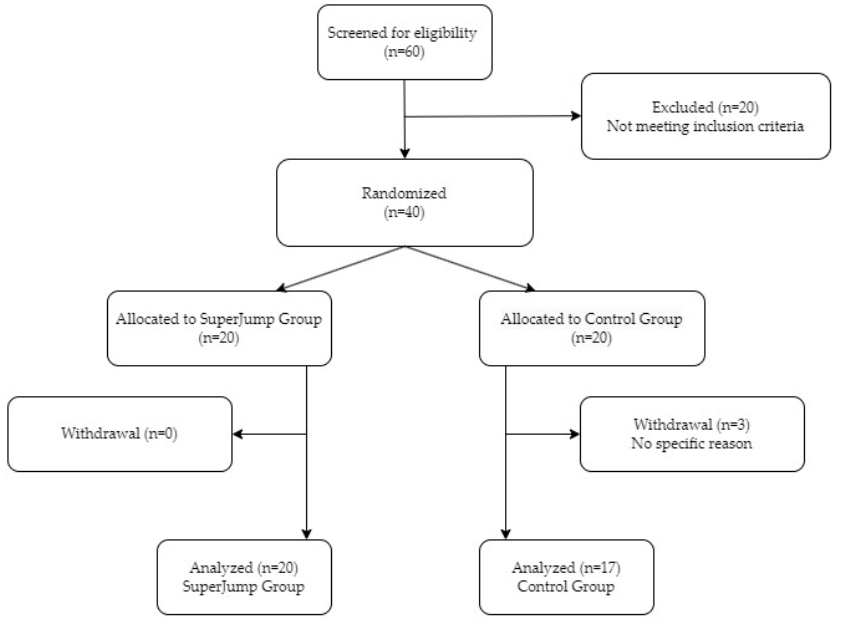
Figure 1. Flow chart of the recruitment and selection process of the subjects included in the